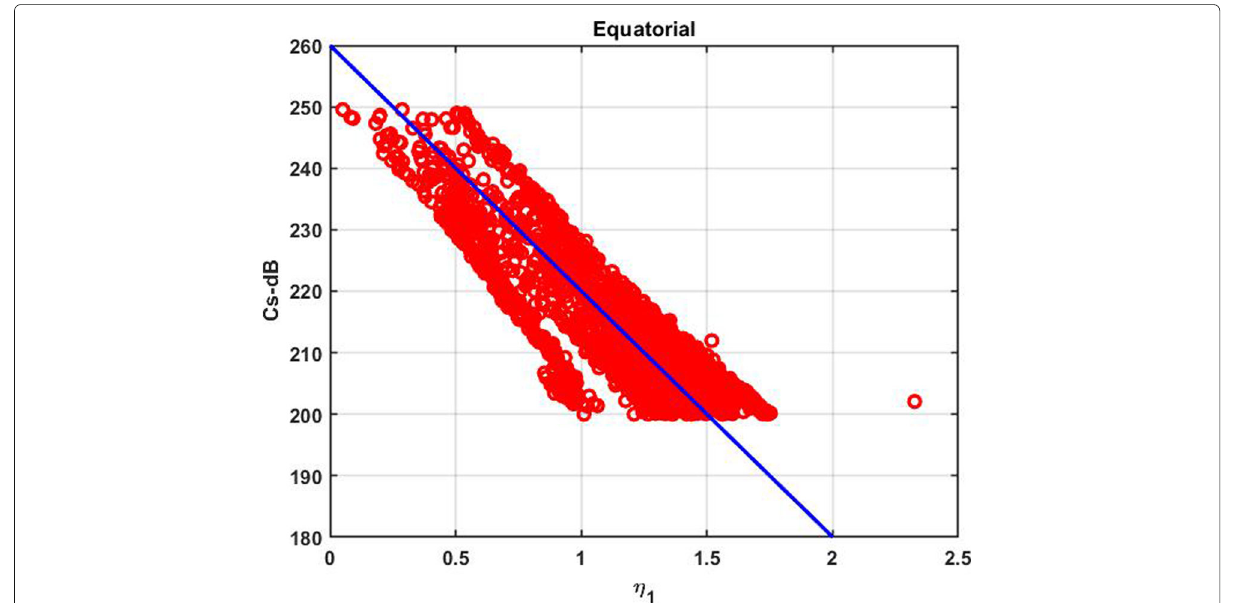
Fig. 15 Scatter diagram of equatorial stochastic structure CsdB values versus η 1 (red), with log-linear overlay (blue)